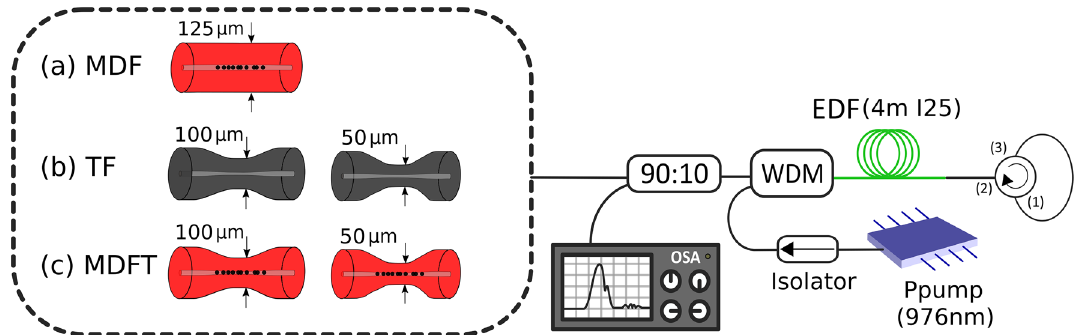
Figure 3. Schematic diagram of the experimental linear short-cavity fiber laser setup, in which ( a ) a micro- drilled optical fiber (MDF), ( b ) un-drilled tapered optical fibers (TF) and ( c ) micro-drilled tapered fibers (MDFT) were used to reflect an amplified